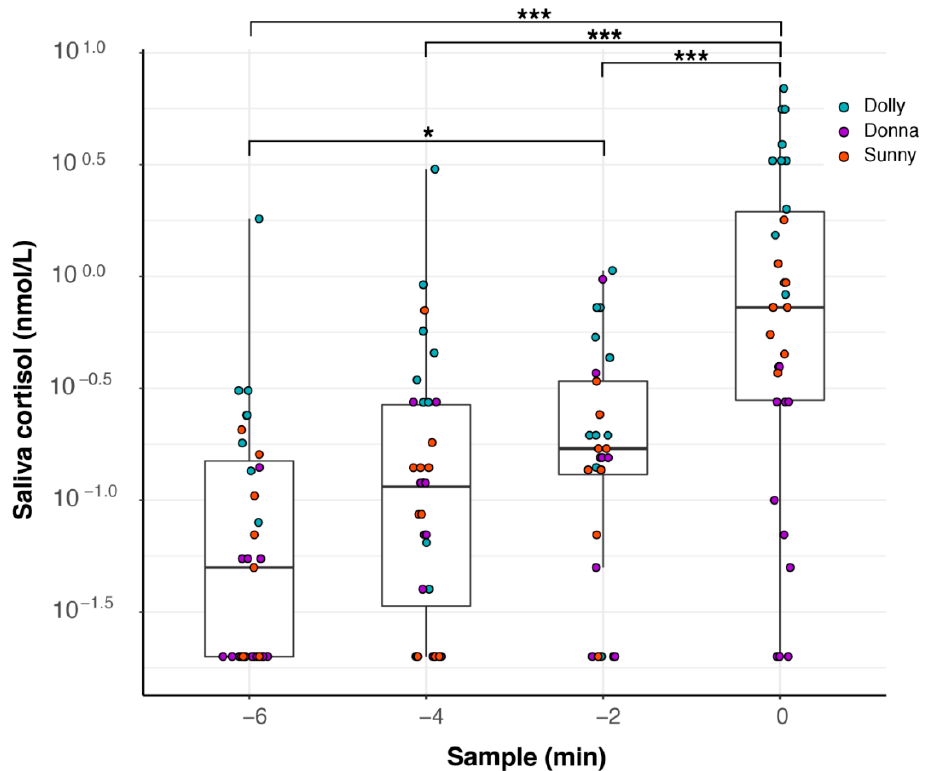
Figure 7. Cortisol values of different fodder fish and cephalopods. We measured samples taken from the thawing water of a 20 kg block of Atlantic herring, a 15 kg block of Baltic herring, a 5 kg block of capelin, a 20 kg block of mackerel, an 8 kg block of sprat and an 8 kg block of squid.